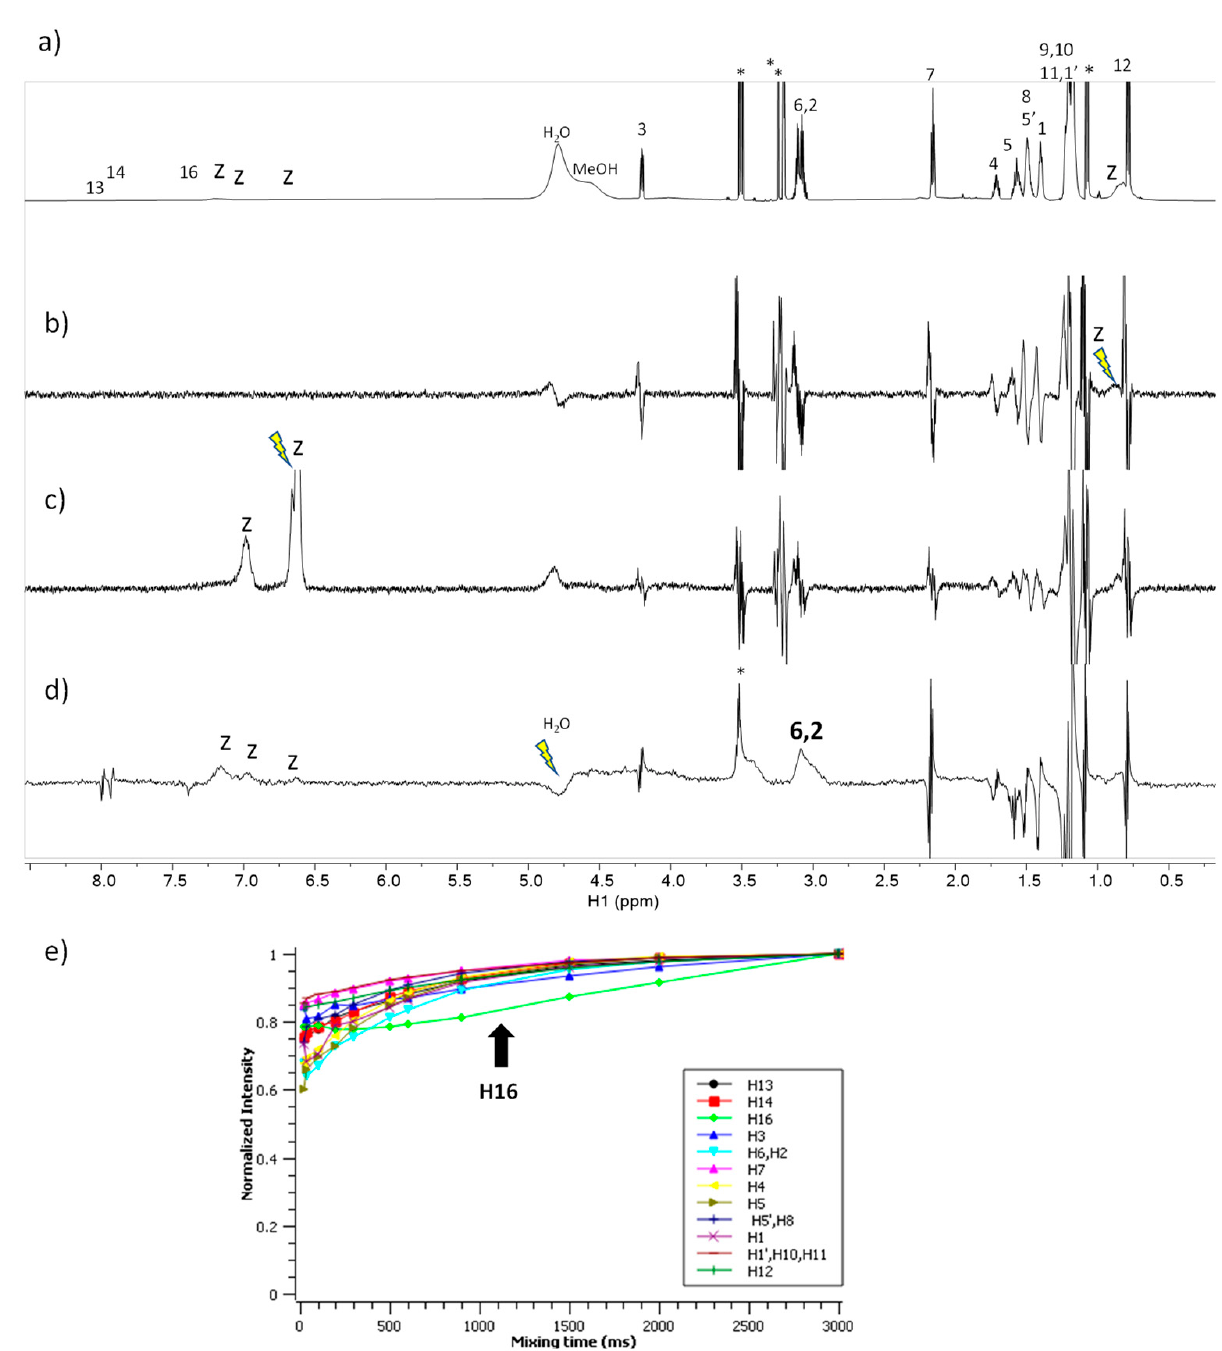
Figure 7. NMR binding interaction study between surfactant C 6 (LA) 2 and zein. ( a ) 1 H NMR ( b , c ) STD off-on with on-saturation applied over the signal of zein at ( b ) 0.82 ppm and ( c ) at 6.5 ppm ( d ) waterLOGSY spectrum with mixing time 500 ms. In ( b – d ) the signal selectively saturated or inverted is indicated with a ray symbol and the assignment of the relevant responses is indicated. Some impurities are denoted with asterisks. The letter z refers to zein signals. ( e ) Plot of the normalized